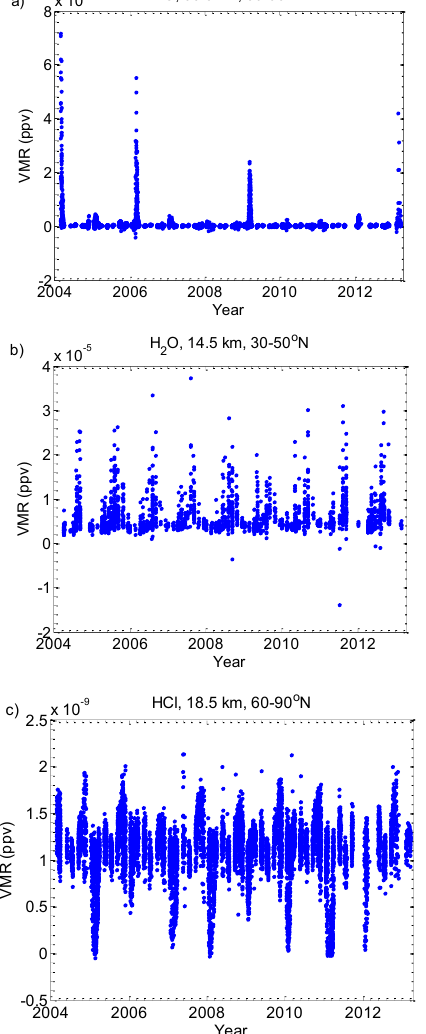
Figure 9. The final inlying data for ACE-FTS: (a) Arctic NO at 55.5km; (b) mid-latitude H 2 O at 14.5km; and (c) Arctic HCl at 18.5km.